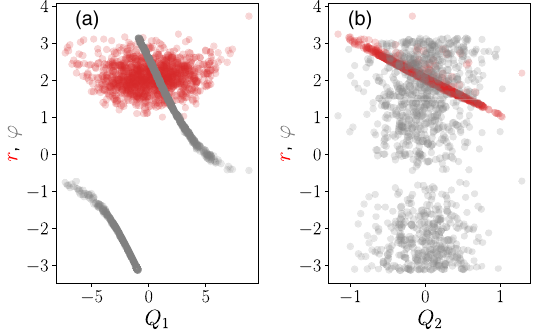
FIG. 2. The Ringworld samples of Sec. IVA projected to the plane of learned latent coordinates and the polar coordinates.